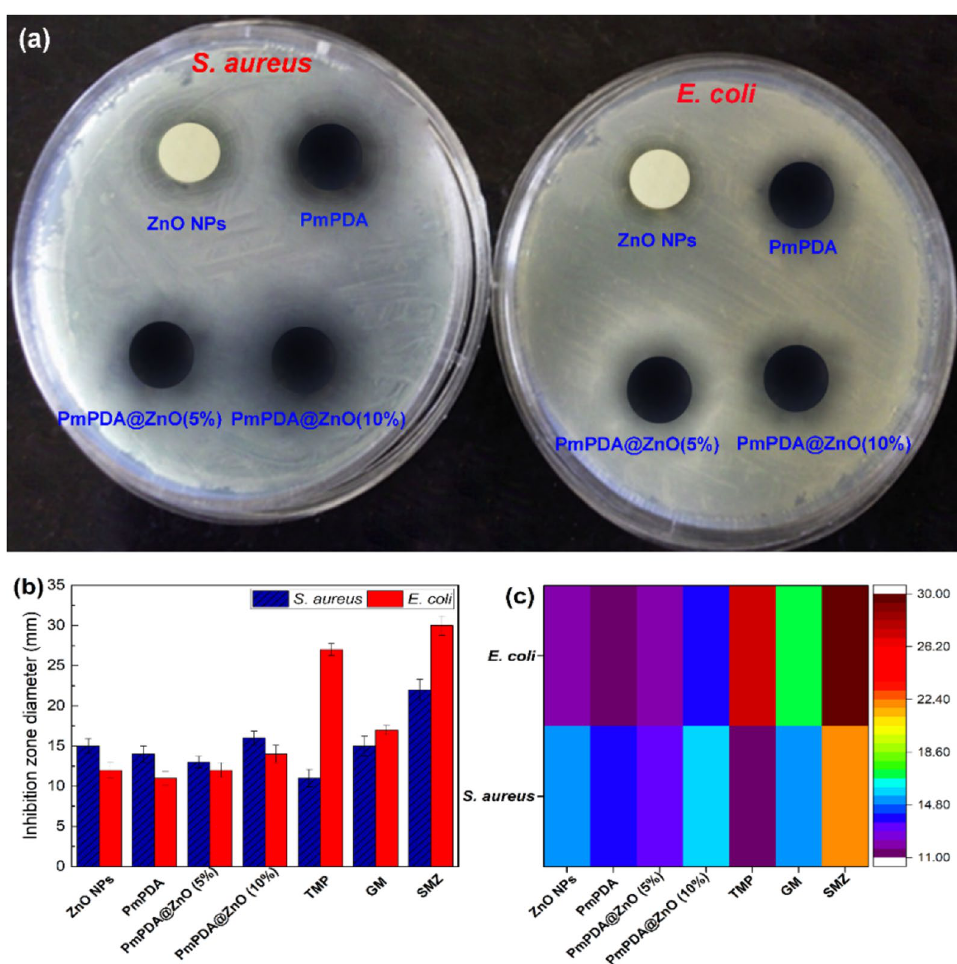
Figure 8. Evaluating antimicrobial activity by agar disk diffusion ( a ), histogram ( b ), and heat map ( c ) of ZnO NPs, PmPDA, PmPDA@ZnO (5%), and PmPDA@ZnO (10%) against bacterial pathogens. Trimethoprim (TMP), sulfamethoxazole (SMZ), and gentamicin